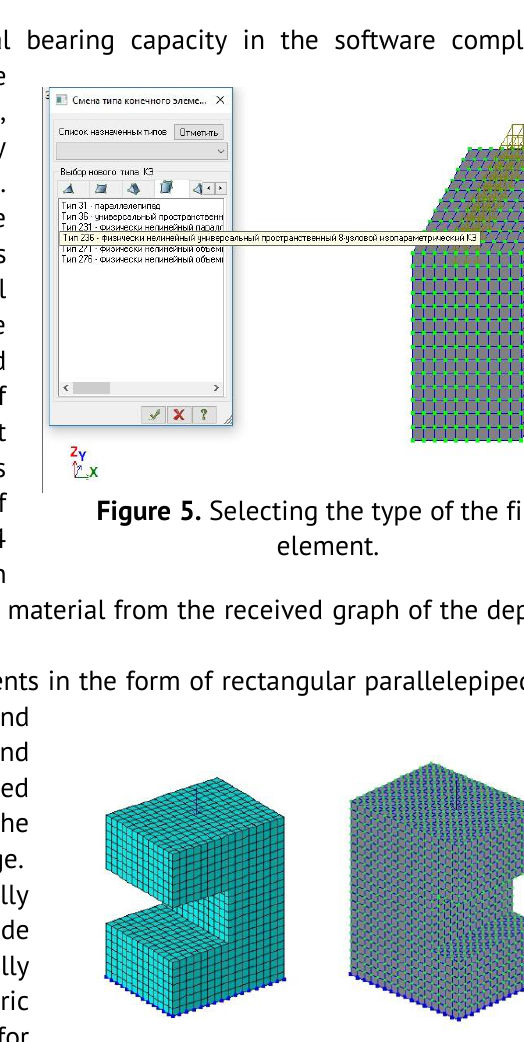
Figure 4. Graph of tension and deformation.